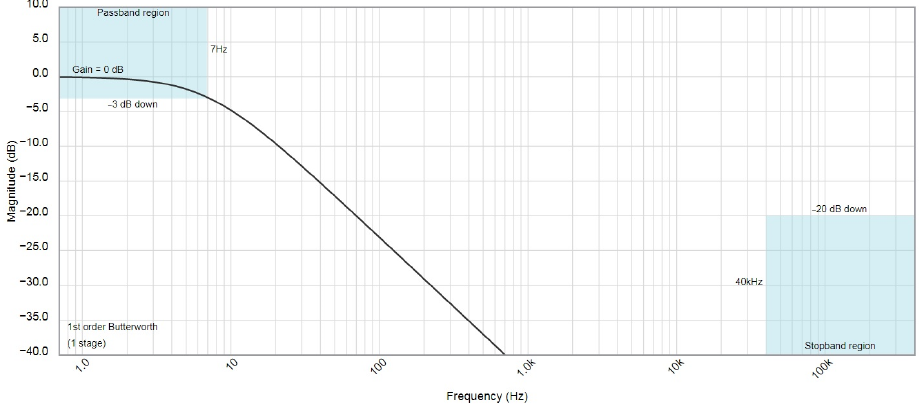
Figure 13. Amplitude frequency characteristics of the low-pass filter.